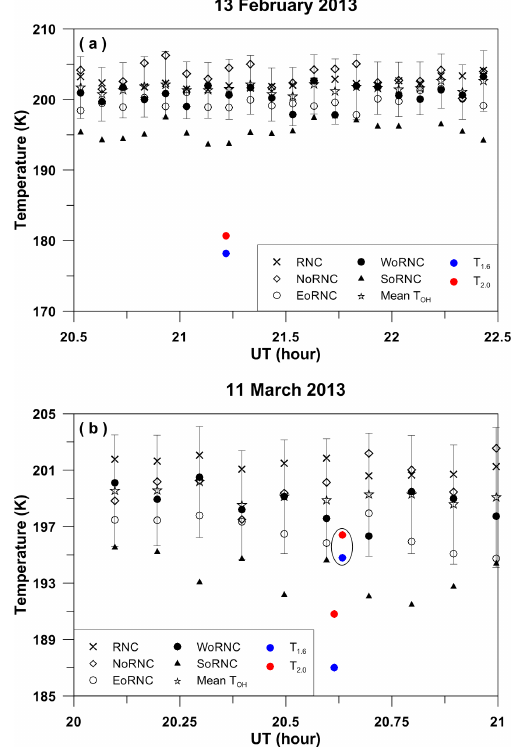
Figure 7. Same as Fig. 6 but for 13 February and 11 March